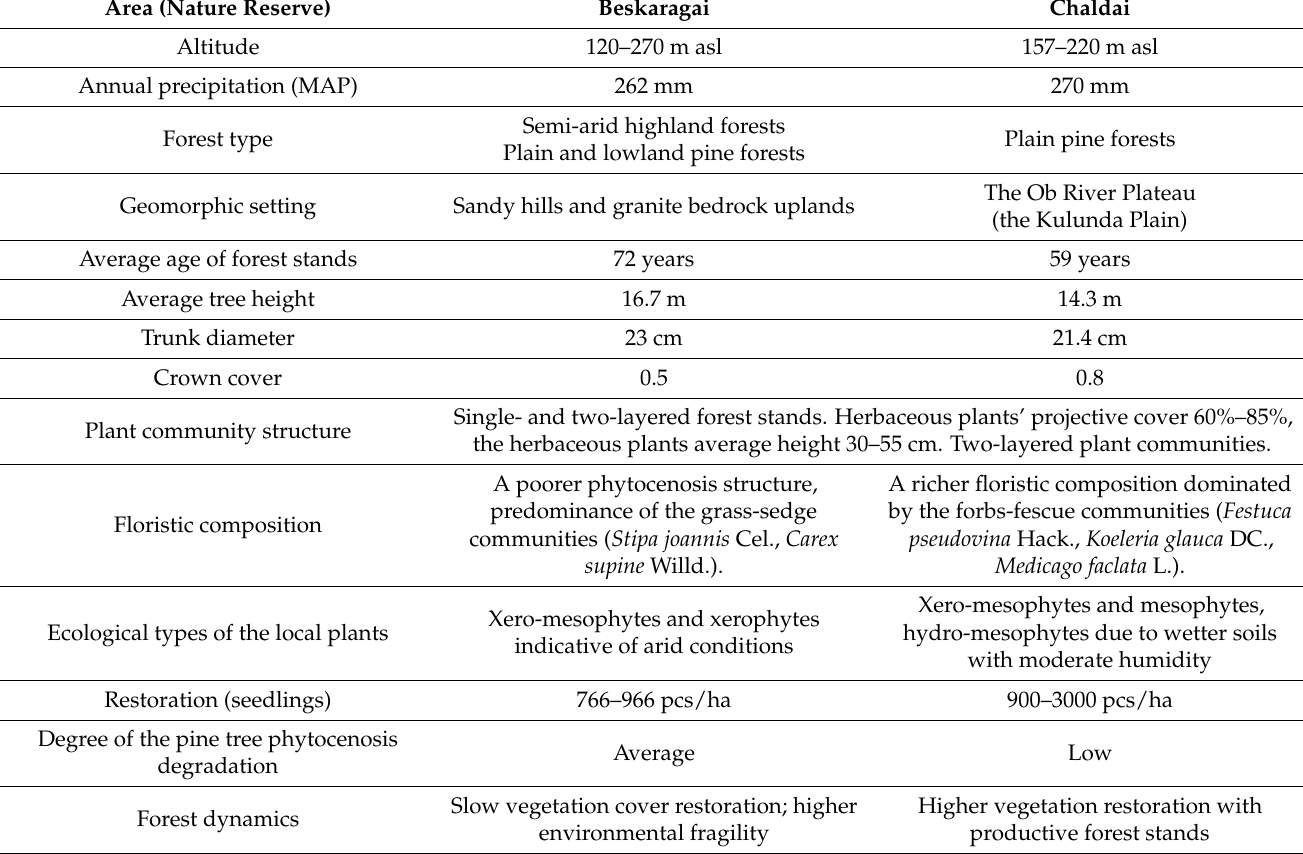
Table 4. Summary characteristics of the Pri-Irtysh ribbon-like pine forests’ growth